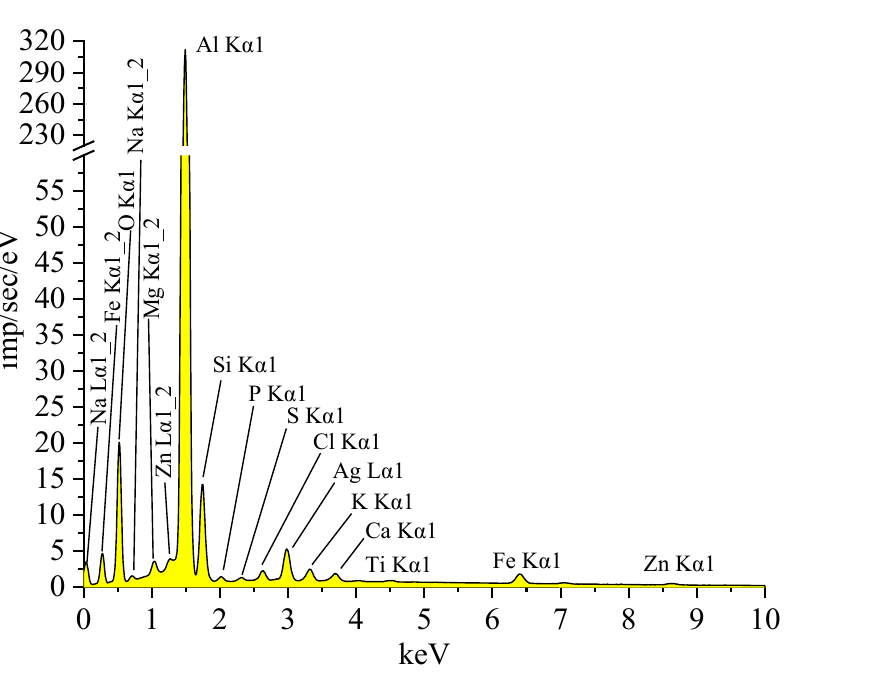
Figure 9. Spectrum of the elemental composition of an electrical aluminum alloy of one of the ABE wire samples. Table 2. Interpretation of the spectra of the elemental composition of an electrical aluminum alloy of the ABE wire samples.